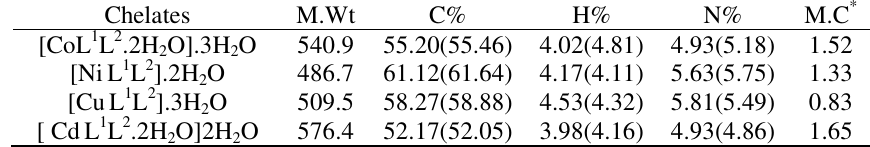
Table 1. Some physical properties of mixed ligand